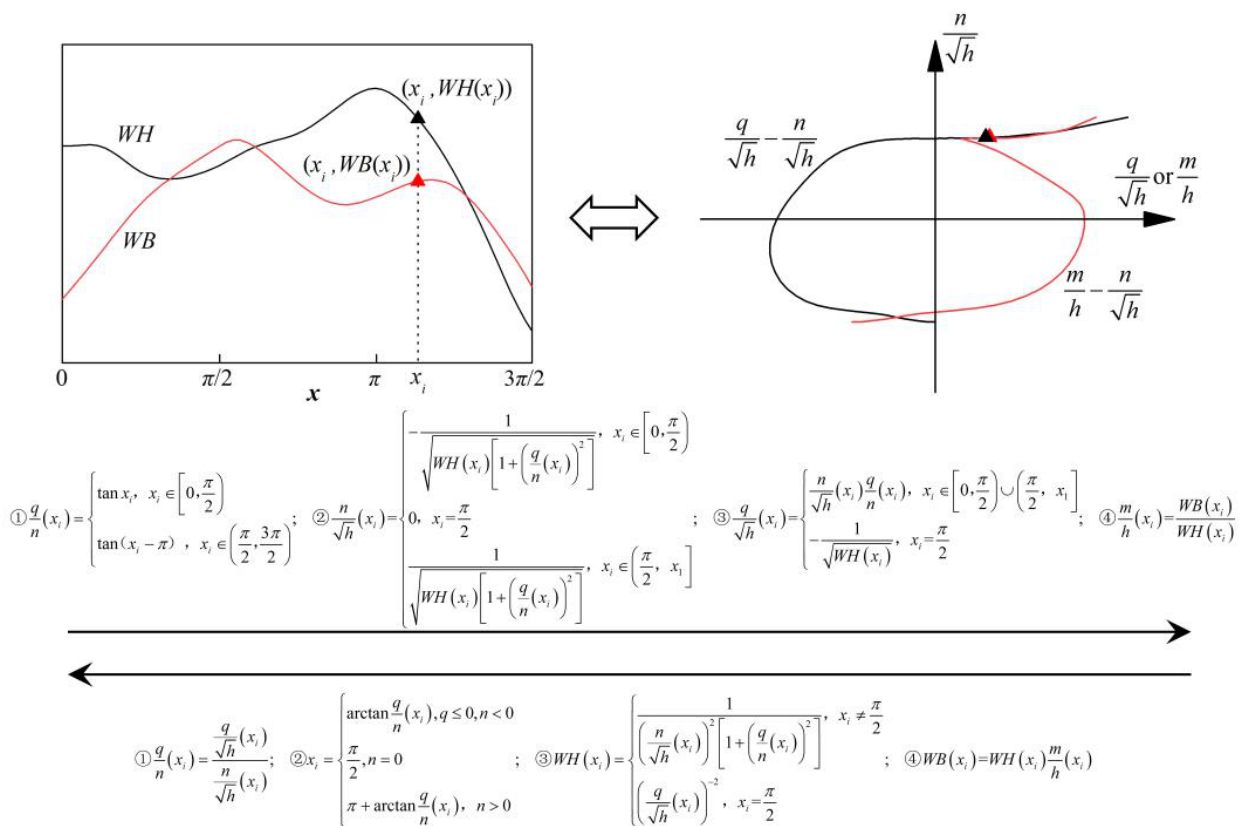
Figure 4. Basic principle of mathematical transformation and inverse transformation of the CPCs.